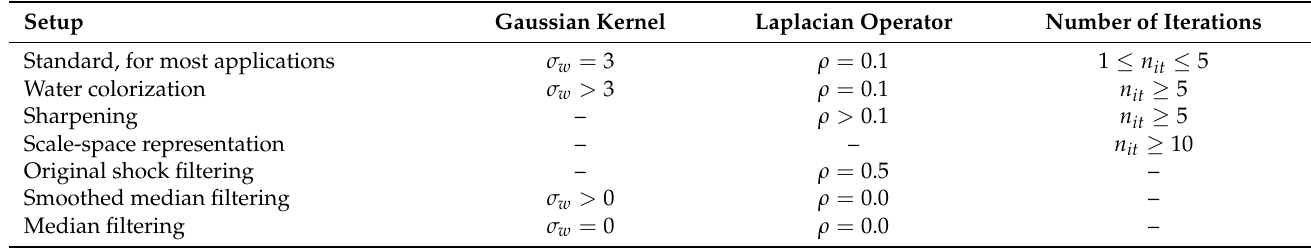
Table 1. Different setups for smoothed shock filtering